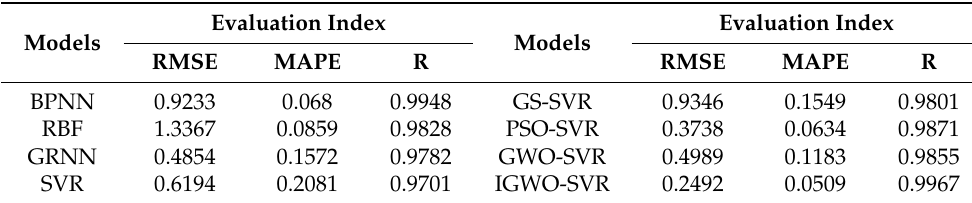
Table 4. Mean results of RMSE, MAPE, and R for four subjects under different regression models at the joint angle of